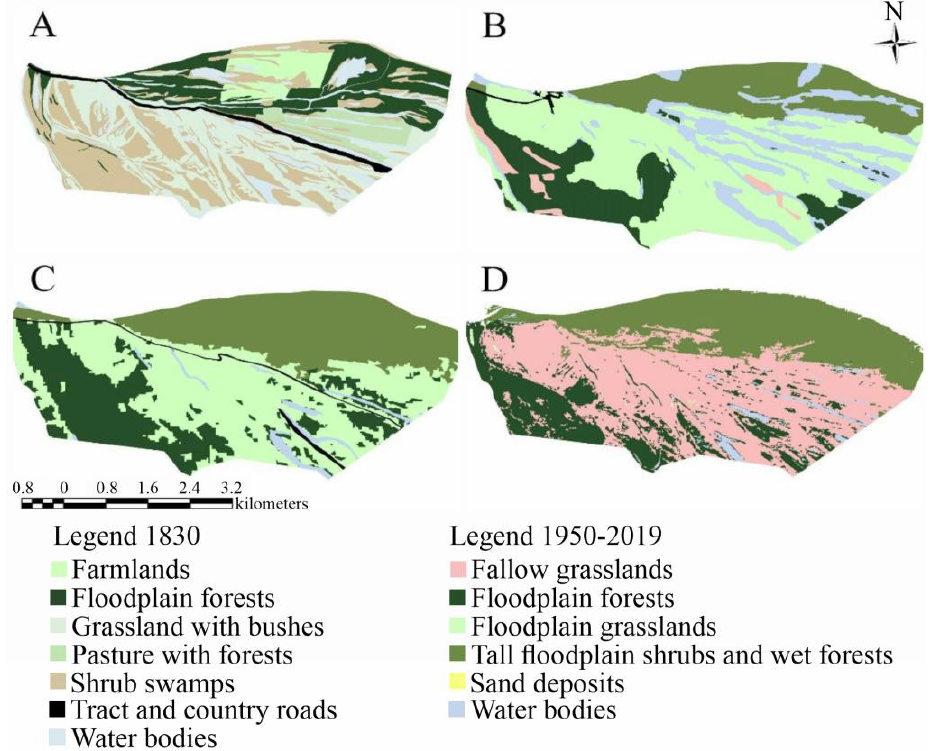
Figure 4. Land-cover and land-use maps of village of Kaibasovo: ( A ) geometrical plan of Kaibasovo from 1910; ( B ) topographic map from 1950s; ( C ) CORONA, 08.1972; ( D ) Sentinel-2A, 08.2019.